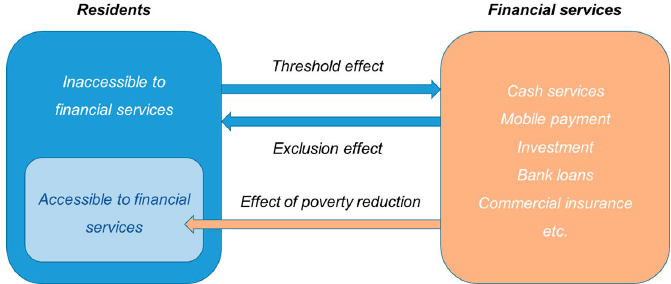
Figure 2. The three effects of financial services on income